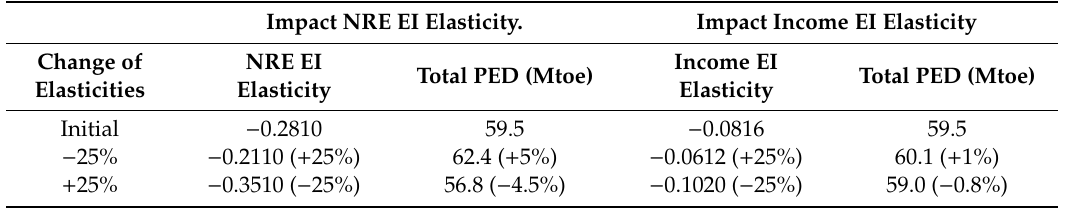
Table 6. Sensitivity of non-renewable energy (NRE) energy intensity (EI) elasticity and income EI elasticity on total